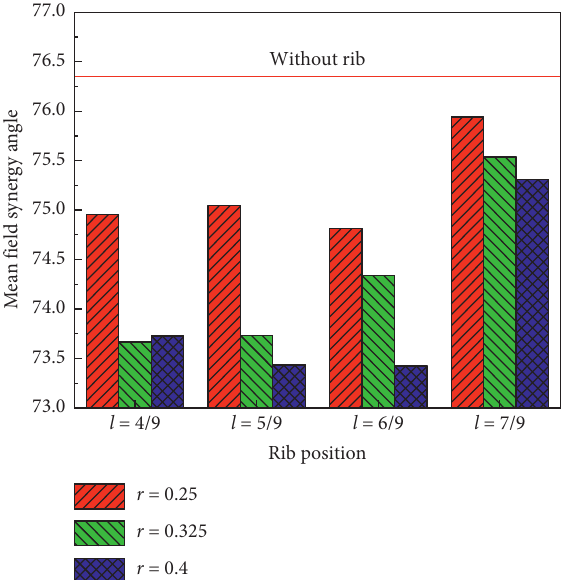
Figure 12: Mean field synergy angle at different rib positions and heights.